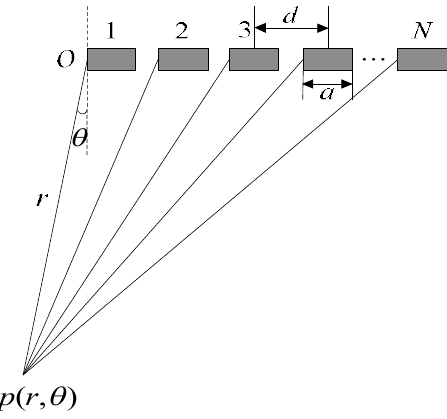
Figure 3. Schematic diagram of the sound pressure calculation of the phased array transducer.